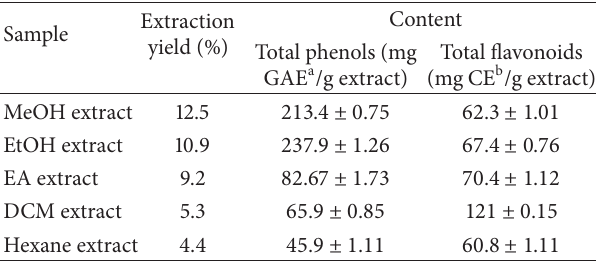
Table1:Extractionyield,totalphenolic,andtotalflavonoidcontents of E. hirta aerial